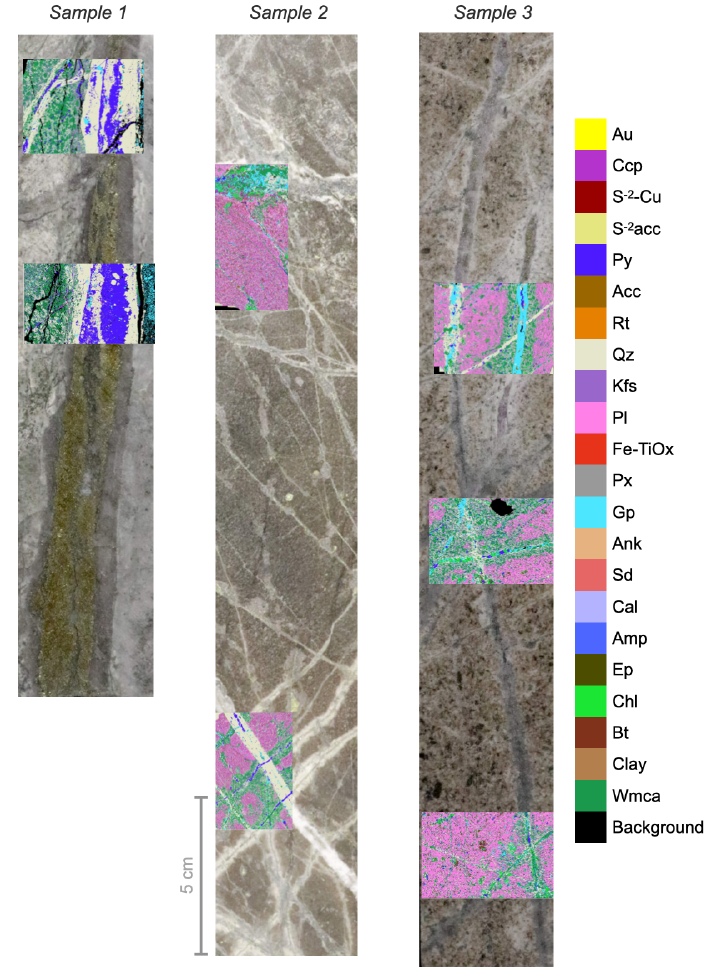
Figure 2. RGB images of the drill-core samples used in this study with the overlaid SEM-MLA images. The pixel size in the original SEM-MLA images is about 3 µ m. (Wmca—white mica, Bt—biotite, Chl—chlorite, Ep—epidote, Amp—amphibole, Cal—calcite, Sd—siderite, Ank—ankerite, Gp—gypsum, Px—pyroxenes, Fe–TiOx—Fe–Ti oxides, Pl—plagioclase, Kfs— K-feldspar, Qz—quartz, Rt—rutile, Acc—accessory minerals, Py—pyrite, S − 2 acc—sulphides accessory, S − 2 -Cu—copper sulphides, Ccp—chalcopyrite, and